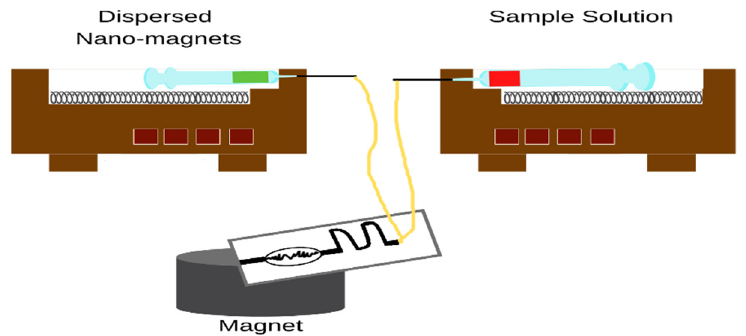
Figure 1. Schematic representation of the extraction set up for MSPE on microfluidic device.